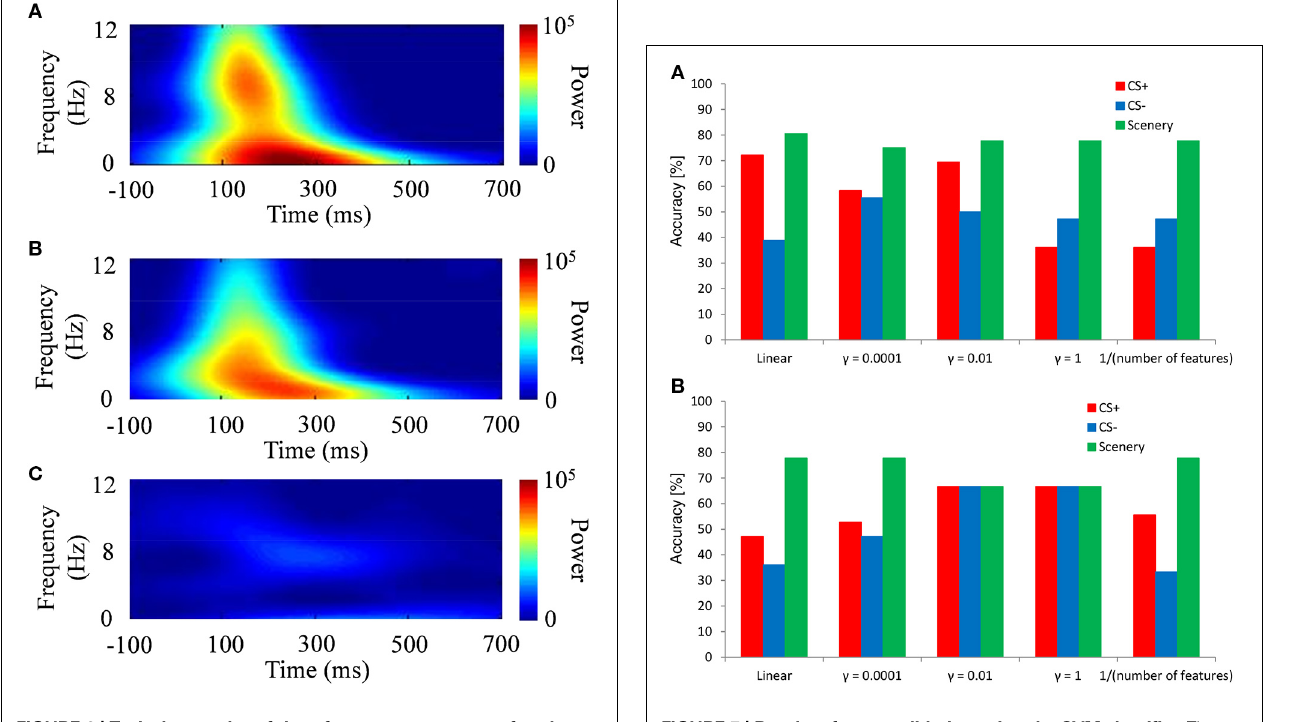
FIGURE 6 | Typical examples of time–frequency responses after the wavelet transform. (A) CS + , (B) CS − , and (C) scenery.